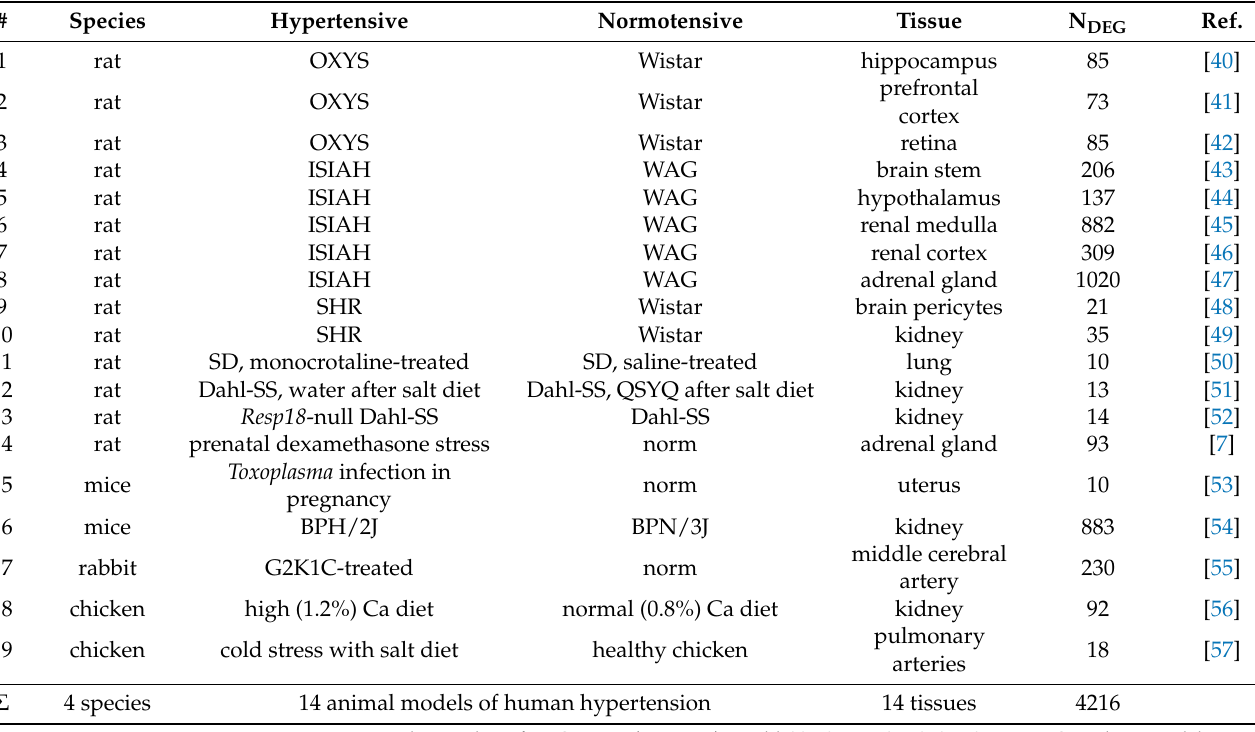
Table 4. The DEGs—of hypertensive versus normotensive animals—that we could find (available in PubMed